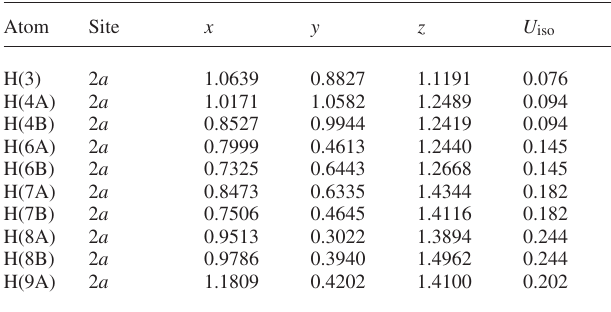
Table 2. Atomic coordinates and displacement parameters (in Å 2 )